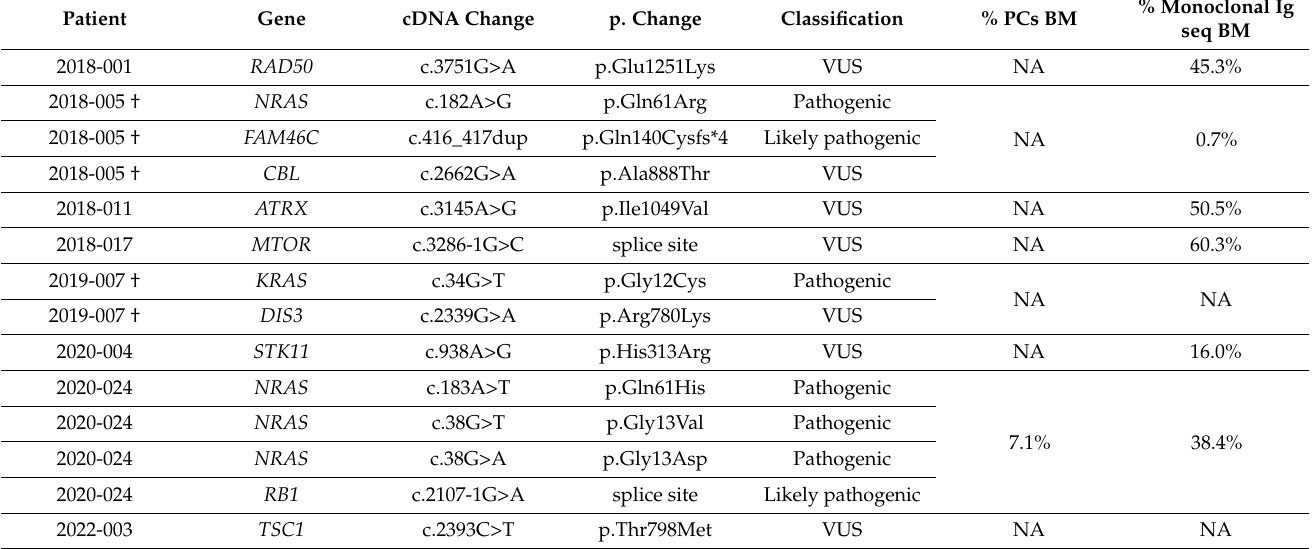
Table 4. Somatic variants selectively detected in circulating biomarkers. This table gives an overview of the somatic variants that were only detected in circulating biomarker DNA ( n = 14) and not in matched BM-DNA samples. Patients in whom extramedullary disease was strongly suspected are indicated with a dagger. NA = not